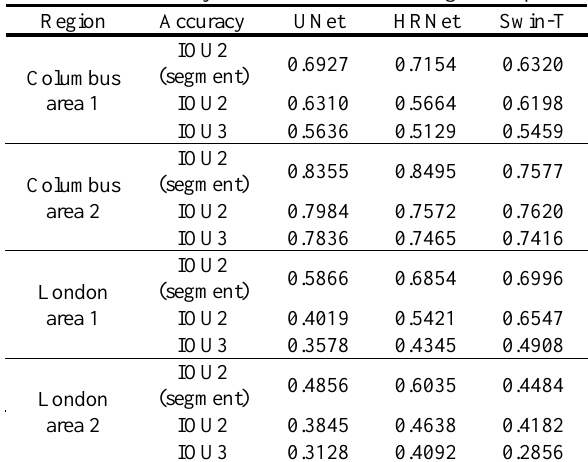
Fig. 4. Example result for London-area-1. First column from up to bottom: Orthophoto, DSM, building segmentation map using HRNet, with OSM street lines. Second column: 3D building model and detailed view of two specific areas Table. 2. Accuracy evaluation of different segment